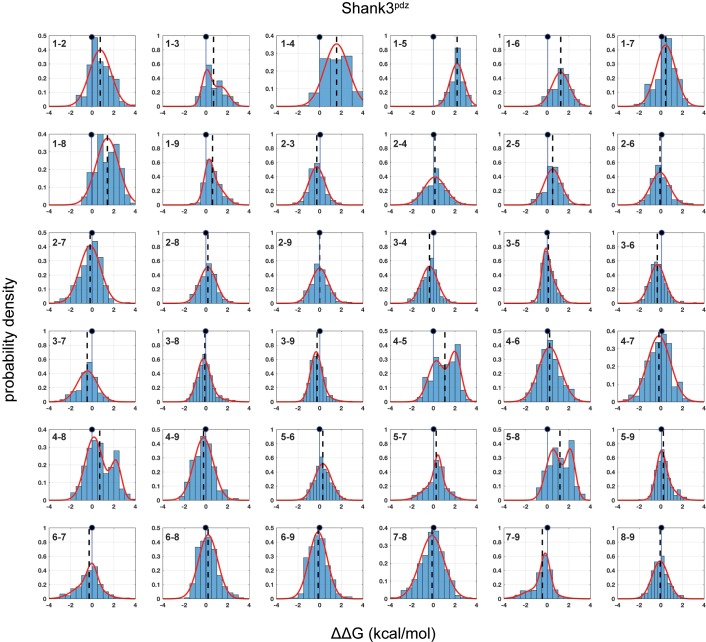
Distributions of double mutant cycles for each α2 helix position pair (numbering as in Figure 1C) for Shank3pdz.As in Figure 3. 2–3, distributions are fit to single or double Gaussians, using the Bayes Information Criterion to choose the model. The position of zero coupling is indicated by the solid line and circle above, and the population weighted mean is represented in dashed lines.